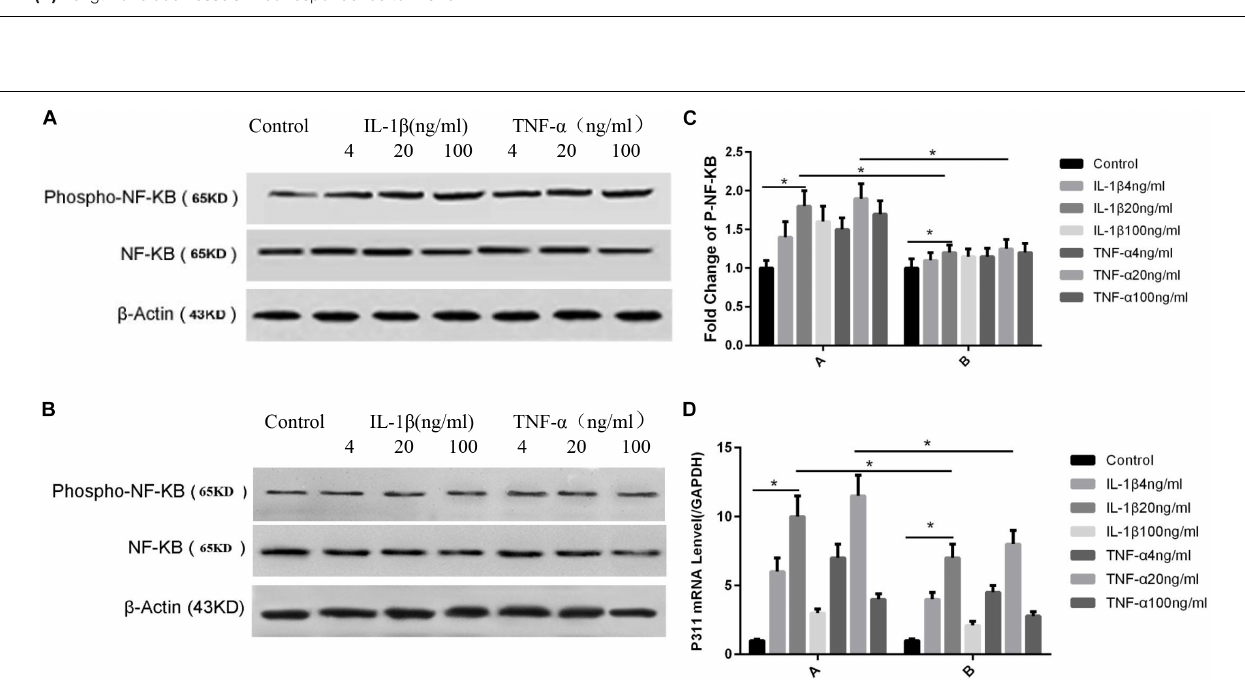
FIGURE 4 | Influences exerted by IL-1 β and TNF- α on NF- κ B phosphorylation and P311 mRNA expression. Mean ± standard deviation (SD) denote the experimental results; * indicates P < 0.05. (A) Samples without P311 siRNA intervention. (B) Samples with P311 siRNA intervention. (C) Corresponding NF- κ B phosphorylation level changes in A and B . (D) A indicated P311 mRNA level without the NF- κ B inhibitor CAPE and B indicated P311 mRNA level when adding the NF- κ B inhibitor CAPE.